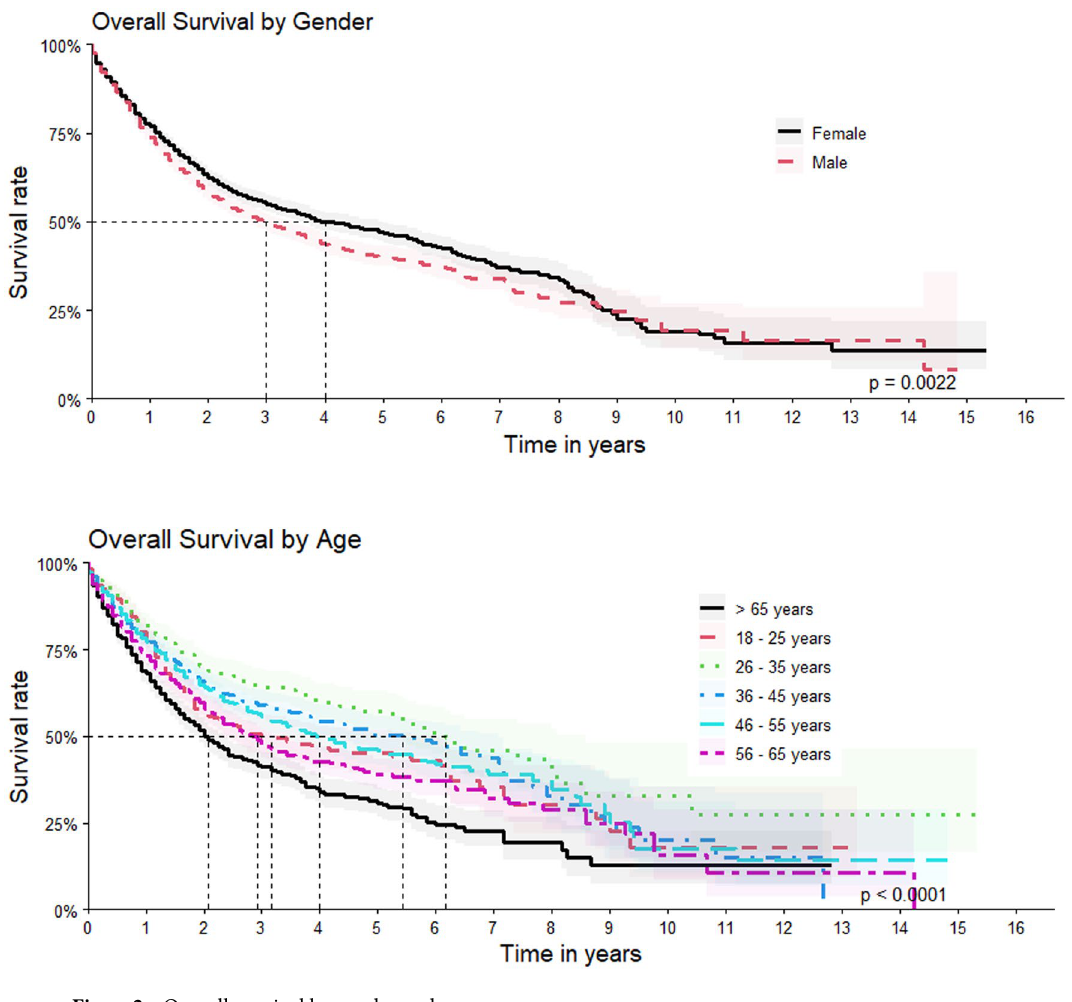
Figure2. Overall survival by gender and